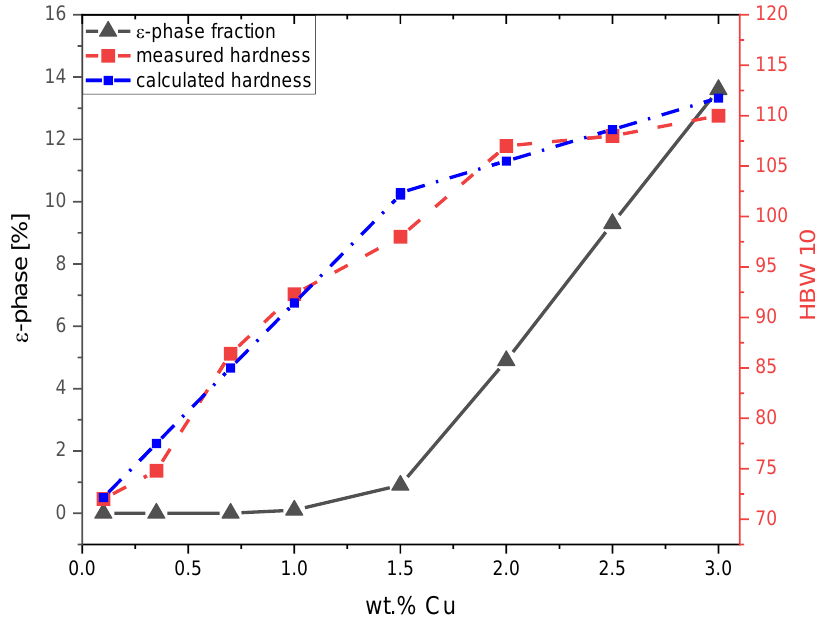
Figure 10. Hardness and ε-phase fraction of ZnAl5.5Cu x for different Cu concentrations.